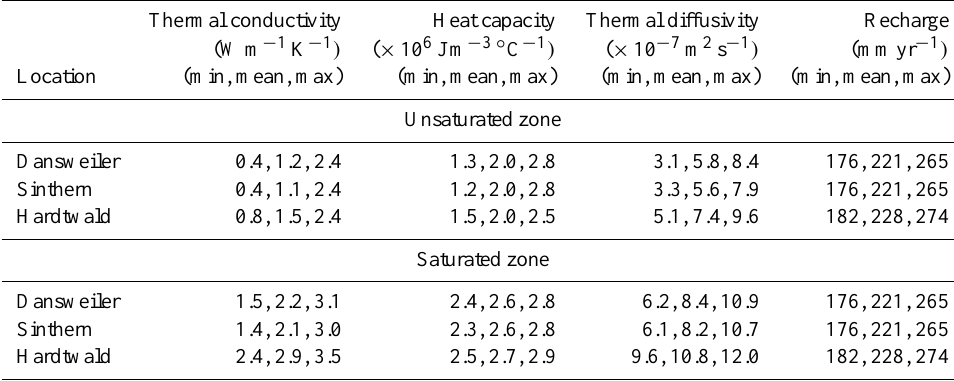
Table 3. Range of thermal properties and recharge values utilized in the analytical solution.